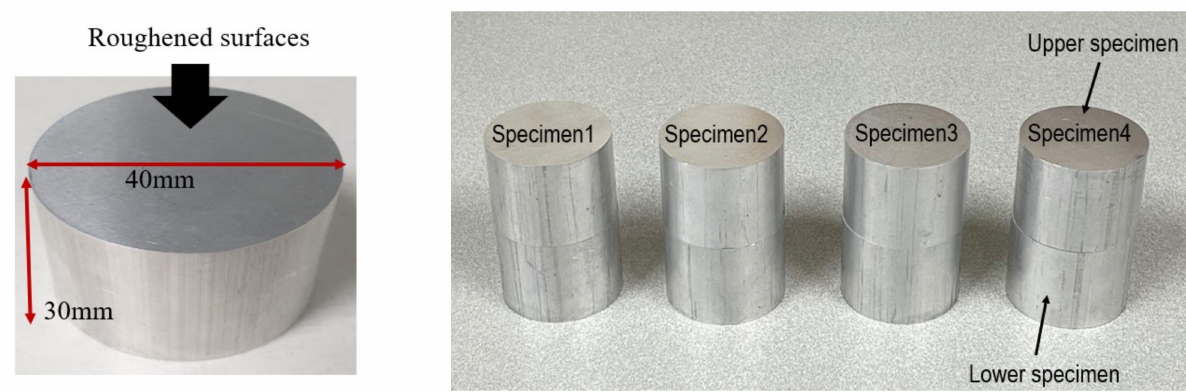
Figure 6. Dimensions of the Al6061-T6 block and four sets of contact interface specimens with different roughness values. The average roughness of the four specimen sets was measured using an optical microscope, and the roughness value (Ra) of each specimen set is shown in Table 1. Figure 7 shows the surface 3D images of the optical microscope.